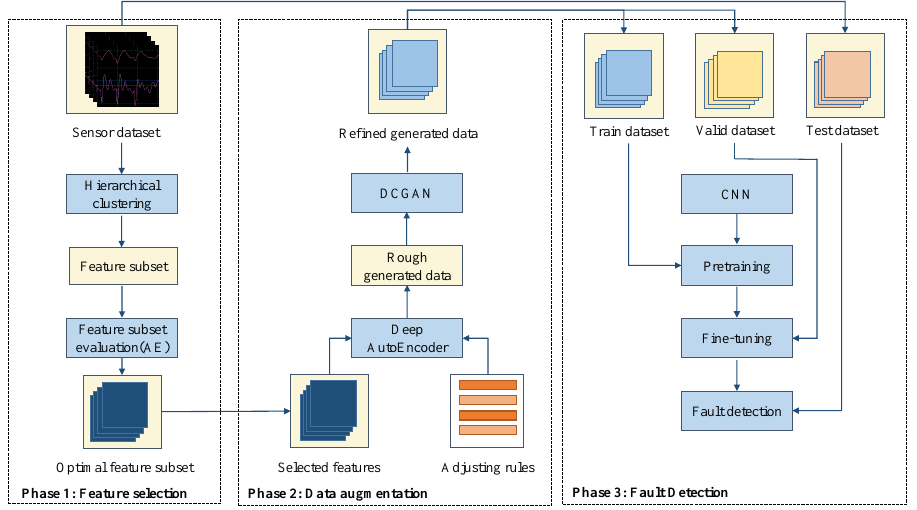
Figure 2. The overall architecture of the proposed fault detection method.